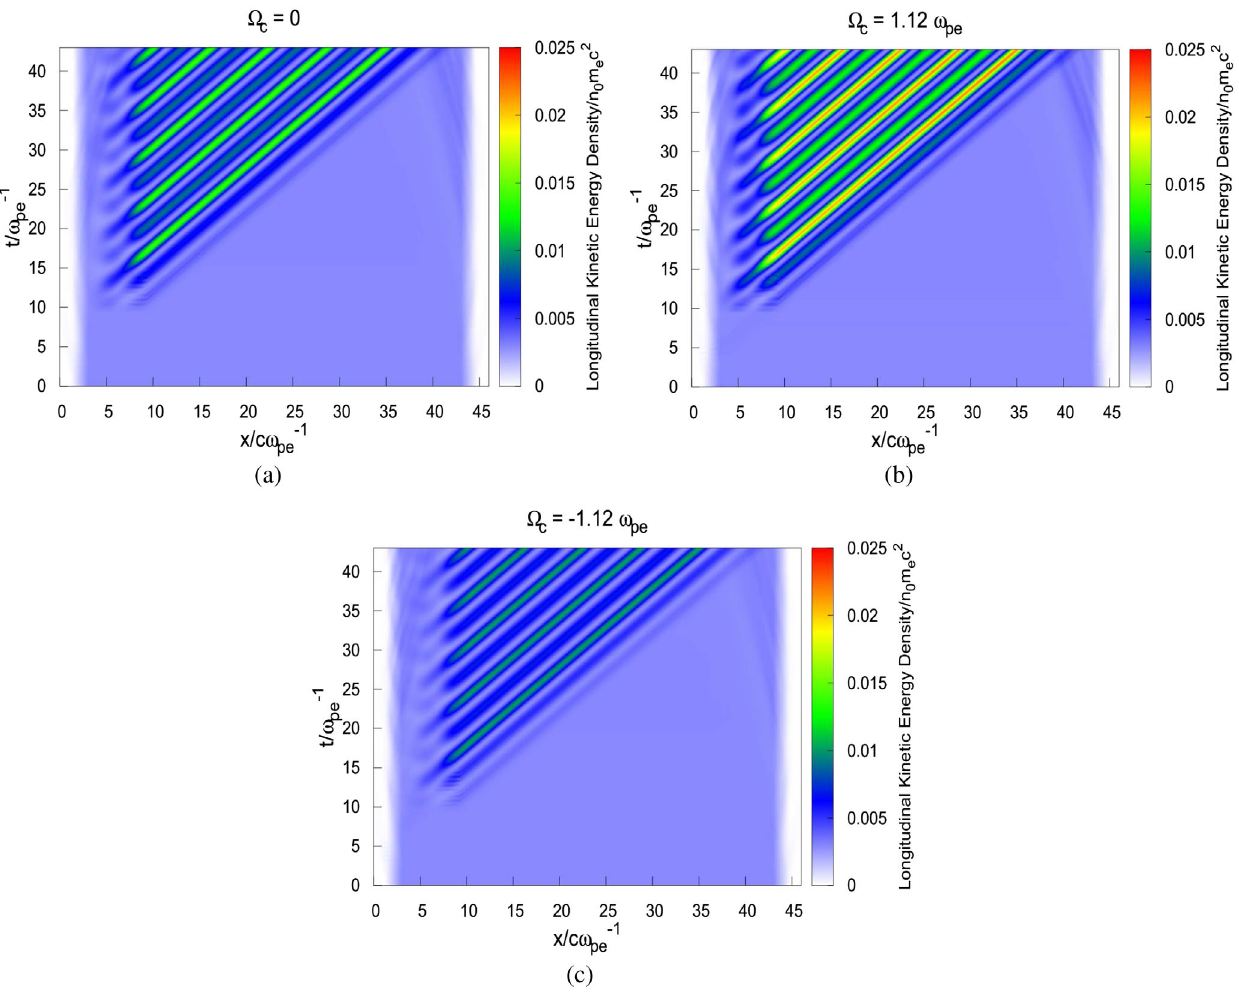
FIG. 7. Time evolution of normalized longitudinal kinetic energy density profile in the ( x; t ) space, which are related to the propagation of RCP laser pulse through (a) nonmagnetized plasma slab Ω c ¼ 0 , (b) plasma slab which are embedded in an external magnetic field in positive x direction Ω c ¼ 1 . 12 ω and (c) plasma slab which are embedded in an external magnetic field in negative x pe direction Ω c ¼ − 1 . 12 ω pe